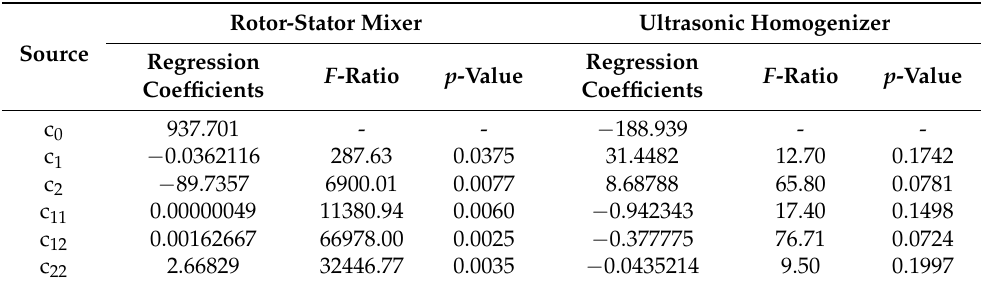
Table 4. ANOVA of the regression coefficients (Equation (1)) for the W/O nanoemulsions prepared by high-energy emulsification